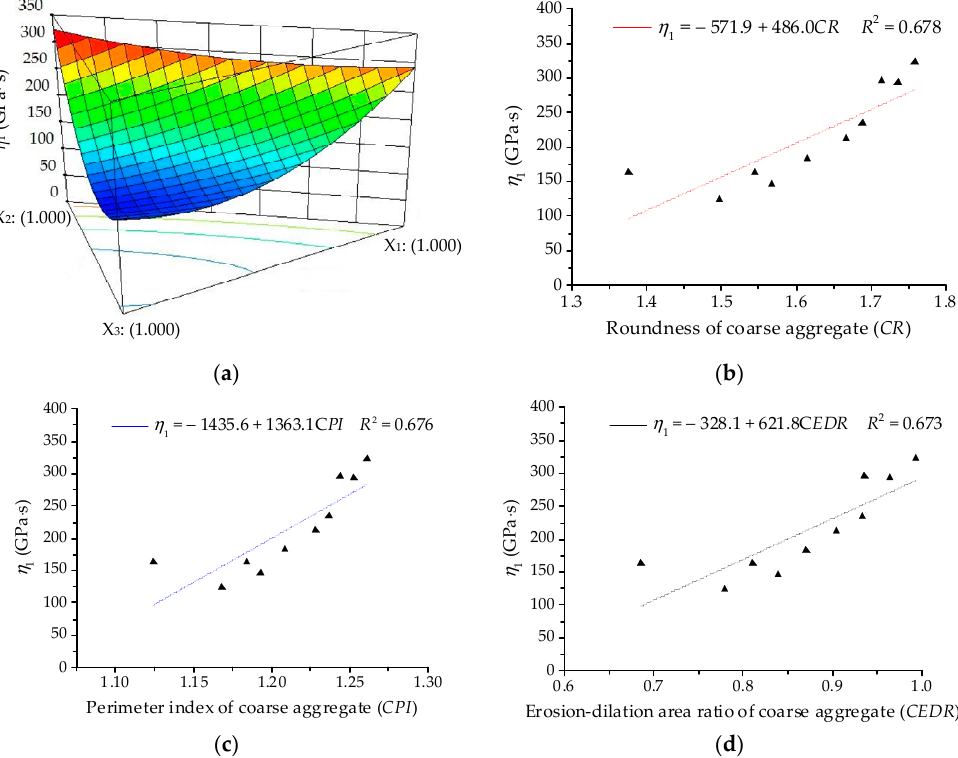
Figure 12. Relationships between η 1 and coarse aggregates: ( a ) Response surface plot for component proportion and η 1 ; ( b ) CR and η 1 ; ( c ) CPI and η 1 ; ( d ) CEDR and η 1 .